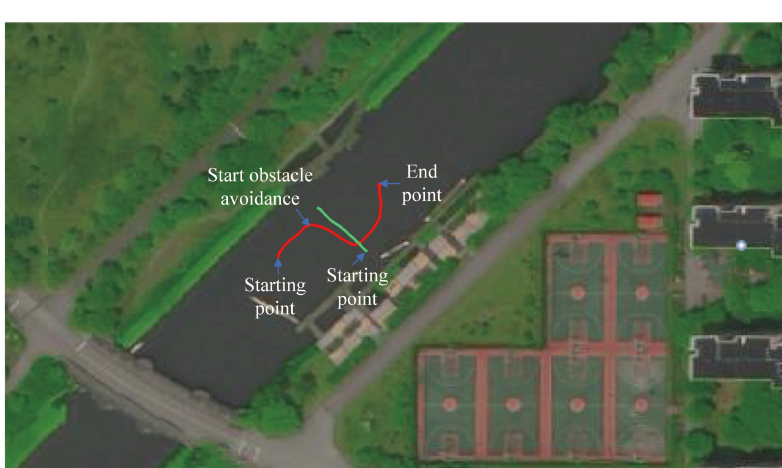
Figure 30. Head-on situation.